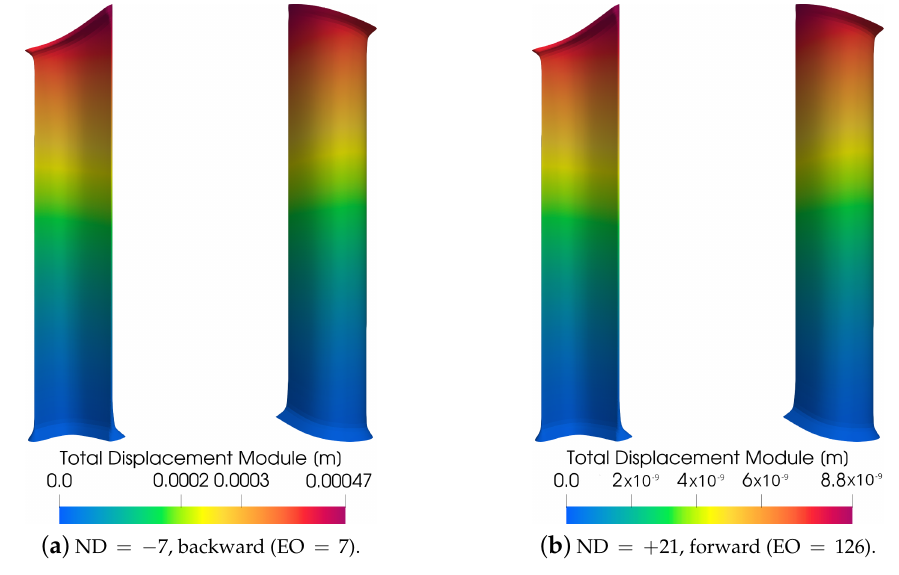
Figure 17. Blade displacement amplitude. Table 4. Tremor–ANSYS comparison (1st